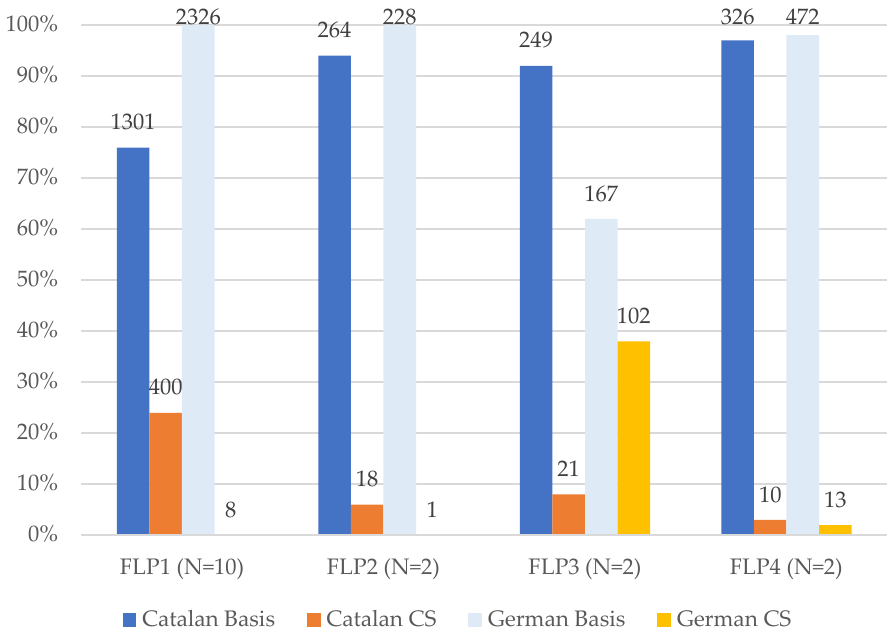
Figure 13. Children’s German and Catalan basis and CS across FLP.